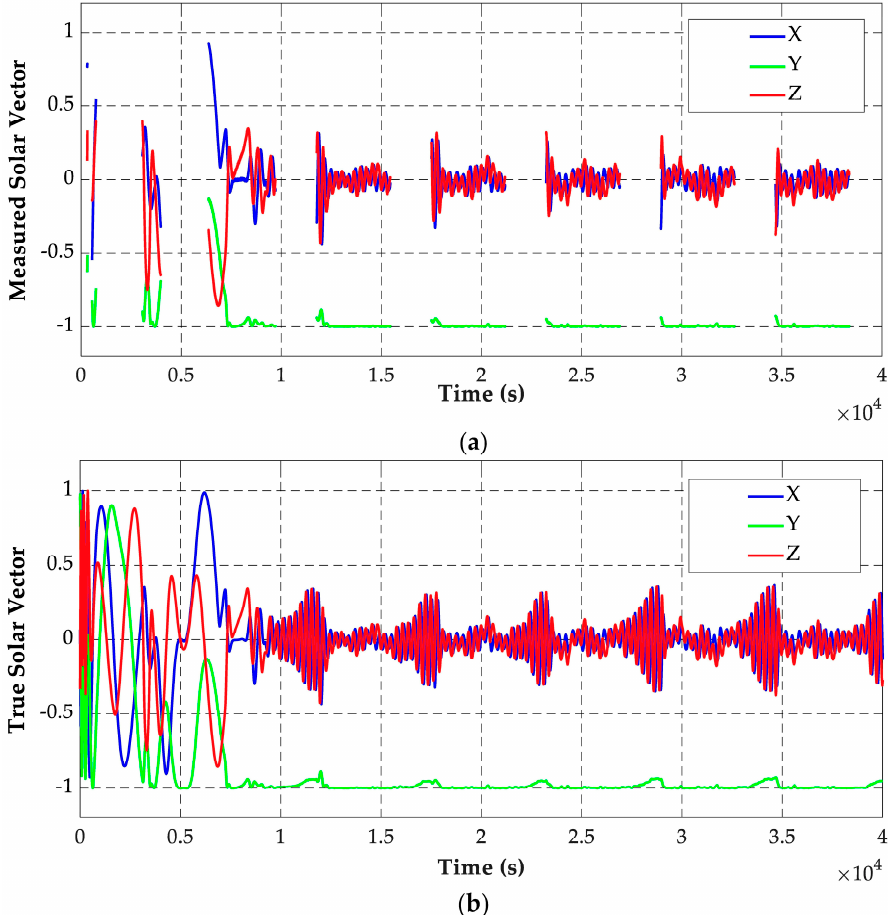
Figure 6. Measured ( a ) and true ( b ) solar vectors.